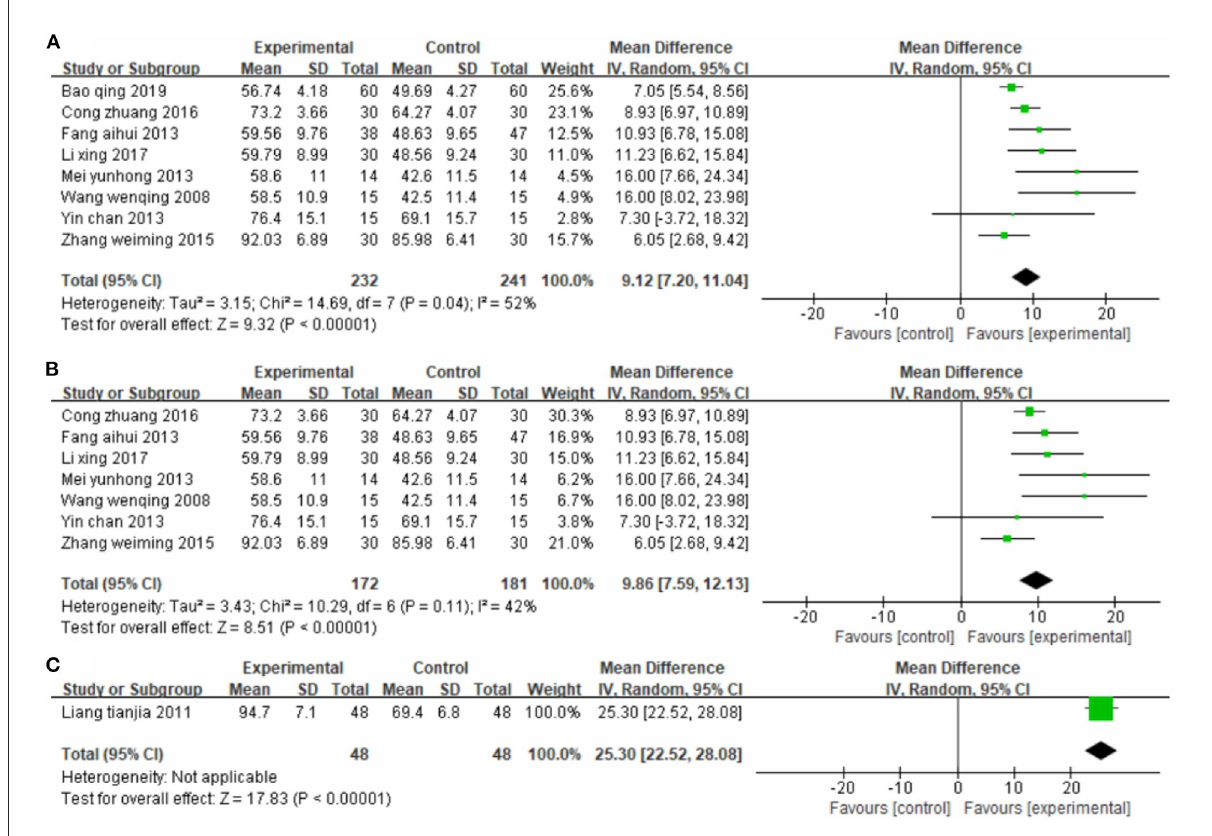
FIGURE6 Forest plot. CIMT vs. conventional physiotherapy on the modified Barthel index (A,B) and functional independence measure (C) .